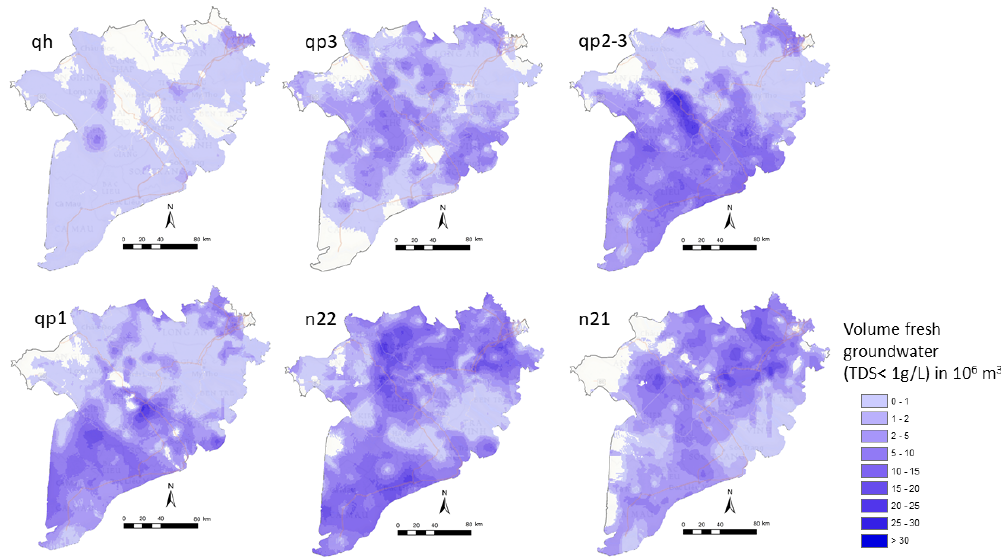
Figure 13. Maps showing the expected depth-averaged volume of fresh groundwater in the aquifers, per 1 × 1km 2 model cell. In blank areas the aquifer is not